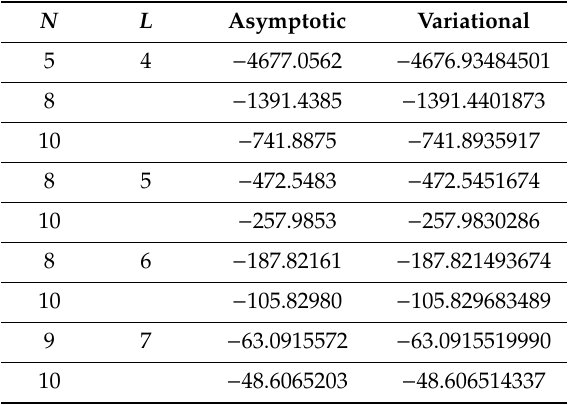
Table 9. Comparison of the asymptotic expansion obtained by Drachman [50] with the variational method of Drake [49]. Energies are in megahertz.